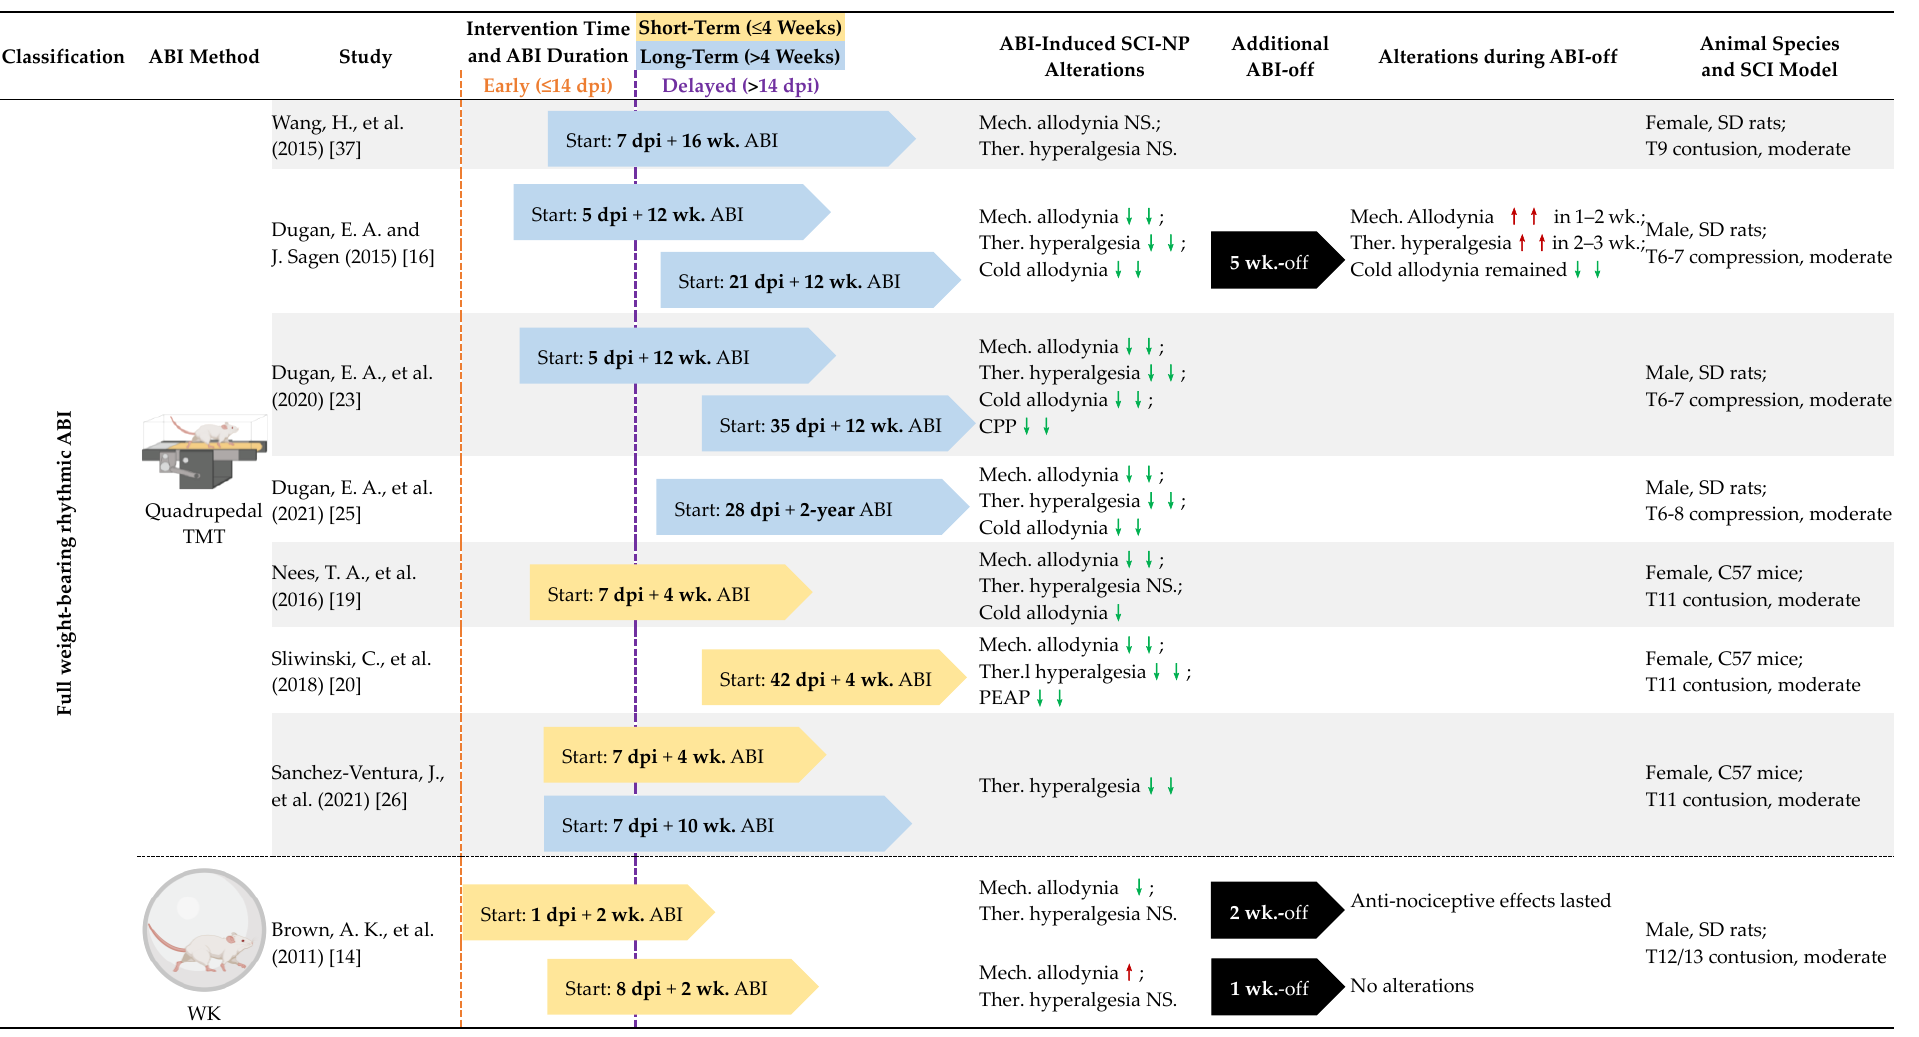
Table 2. Several factors affecting the efficacy of ABI (time of intervention, duration, and weight bearing).